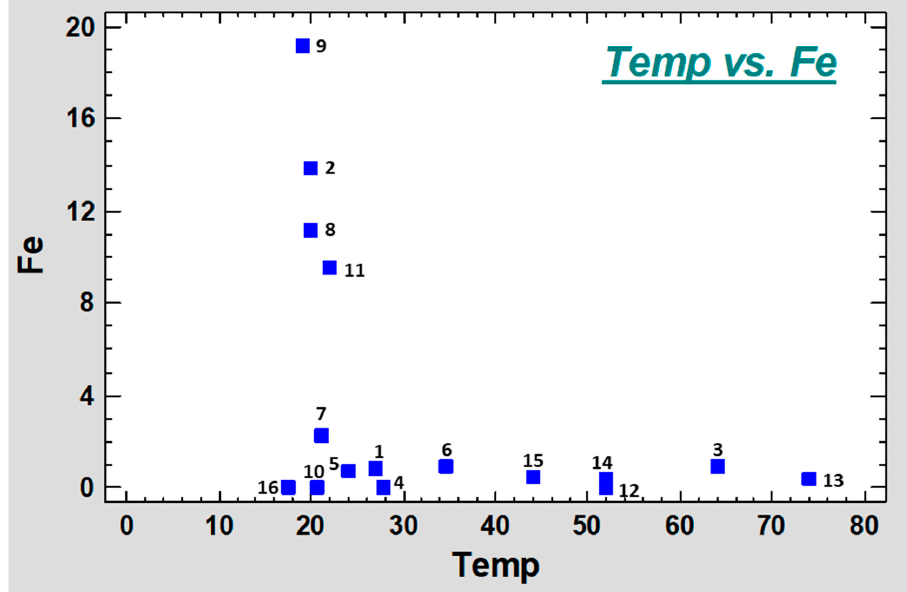
Figure 11. Relationship between temperature and Fe in the geothermal water samples of the Paipa region.